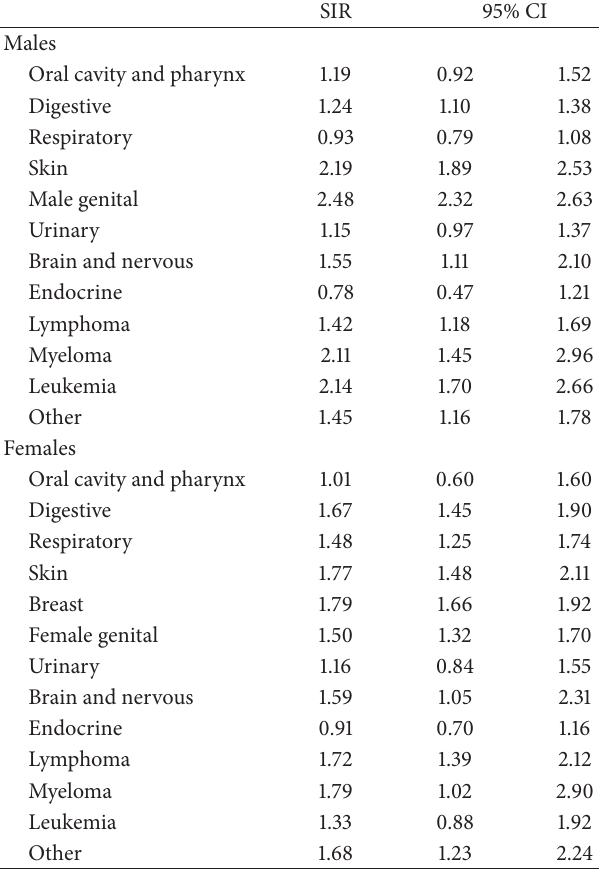
Table 3: Standardized incidence ratio (SIR) by sex and cancer site, allogeneic blood donors with more than one year of followup, Blood Centers of the Pacific, 1991–2009 ( 𝑛 =